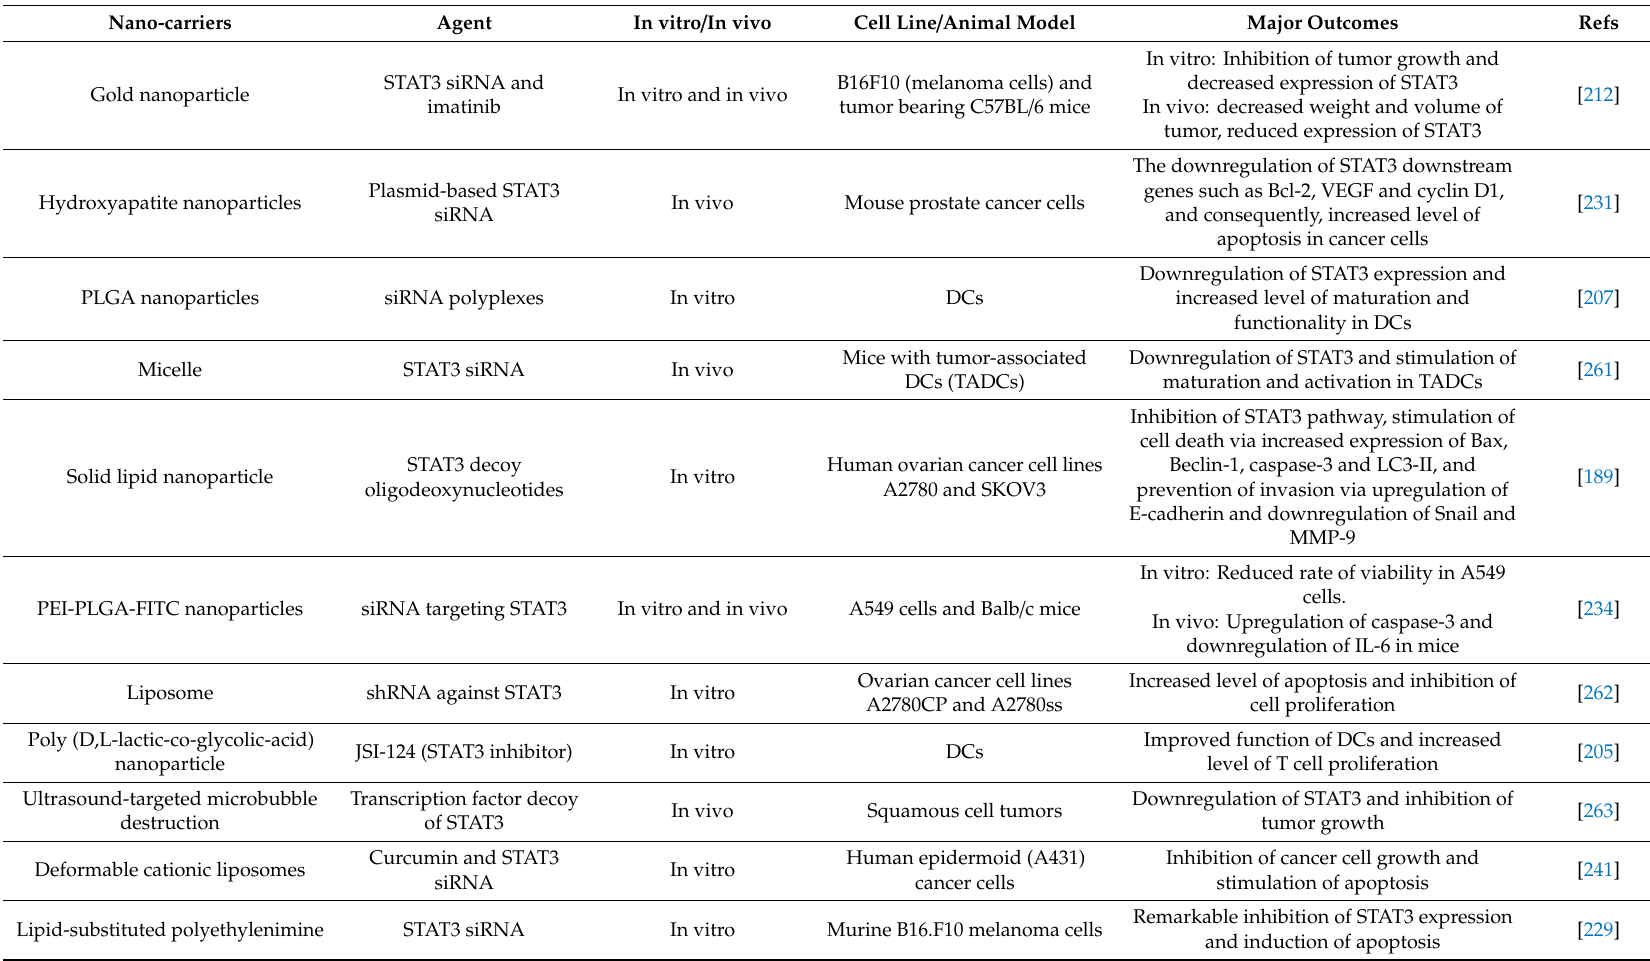
Table 3. Potential use of nanocarriers for delivery of STAT